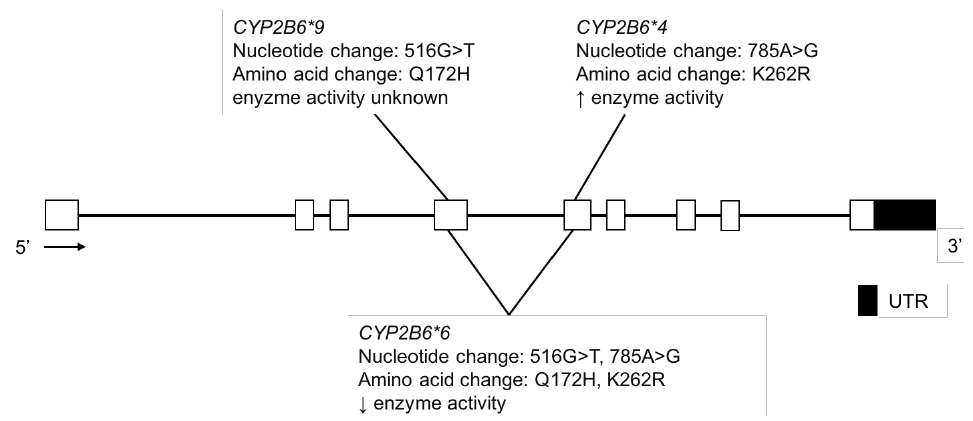
Figure 6. The human CYP2B6 gene and variants tested for in the Yup’ik AN population. Open boxes represent exons, lines represent introns and shaded boxes represent UTR. Table 5. Comparison of CYP2B6 allele frequencies in an Indigenous North American population to global populations from the 1000 Genomes Project [20]. N represents the number of alleles. Global populations are abbreviated as follows: African Ancestry in Southwest US (ASW); Utah residents with Northern and Western European ancestry (CEU); Han Chinese in Beijing, China (CHB); Mexican Ancestry in Los Angeles, California (MXL). For alleles not captured by 1000 Genomes (noted by ‡), the frequencies were extracted from Exome Aggregation Consortium [80] and for alleles defined by multiple variants, the frequencies reported in Zhou et al. [21] using LDLink software [81] were used.